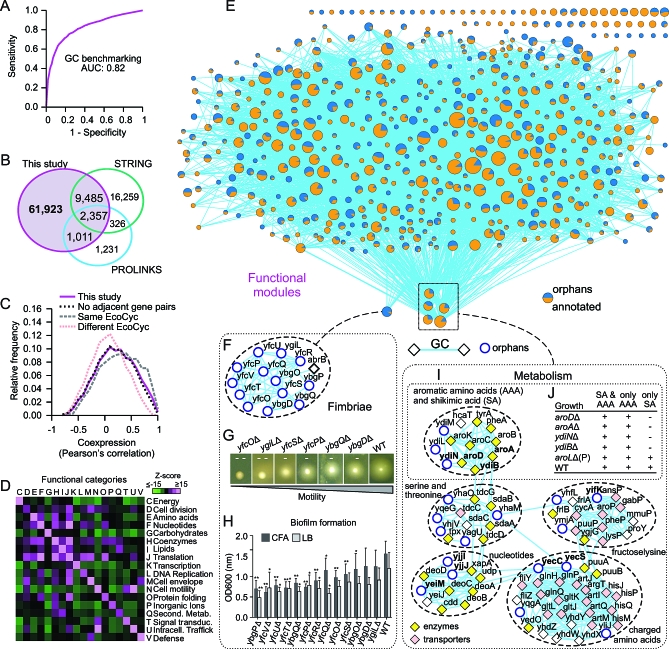
High-Confidence Genomic Context Associations and Putative Functional Modules(A) Benchmarking of unified GC interactions in E. coli against positive and negative gold standards by ROC-curve analysis.(B) Overlap of high-confidence functional interactions predicted in this study with two other public GC databases.(C) Even after eliminating adjacent gene pairs to control for known and predicted E. coli operons, functionally linked genes have highly correlated patterns of mRNA expression comparable to components of the same curated EcoCyc pathways rather than different pathways.(D) Functionally linked genes are enriched for annotations to the same COG functional categories.(E) Graphical representation of putative E. coli functional modules (see Table S9 for listing); node size and colors are proportional to the number and fraction of orphan and annotated subunits, respectively, while lines represent interactions connecting modules. (F) Putative fimbriae-related module.(G) Defective motility of mutant strains deleted for orphans linked to fimbriae (from [F]); single dashes (-) indicate moderately impaired motility, while double dashes (–) represent strong repression. Other mutants displaying a normal phenotype comparable to the wild-type strain BW25113 (WT) are not shown.(H) Defective biofilm formation by mutants deleted for fimbriae-related orphans (from [F]); significant differences (t-test) in cell adhesion (absorbance) between mutant and WT strains are denoted by asterisks (single asterisks [*], p < 0.01; double asterisks [**], p < 0.0001). Error bars indicate standard deviation of the mean. CFA, colonization factor antigen medium; LB, Luria Bertani medium.(I) Metabolic modules mentioned in main text.(J) Mutants auxotrophic for aromatic amino acids show defective growth on minimal media containing shikimic acid. A prototroph—aroLΔ mutant strain (P)—is shown for comparison.